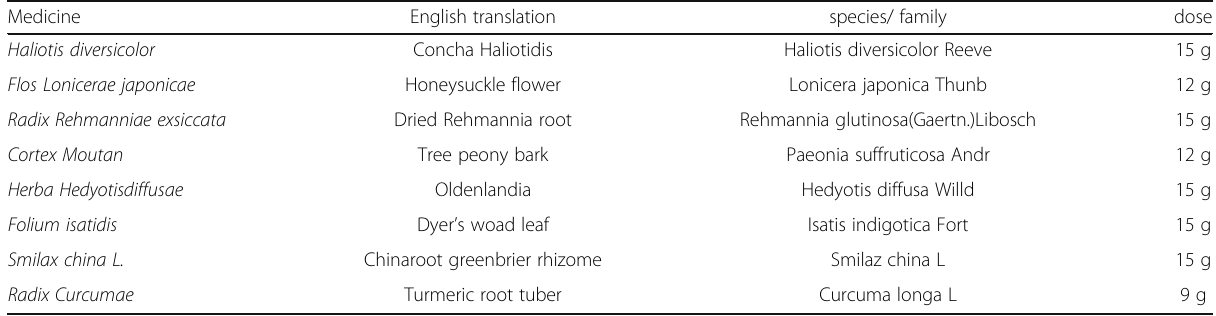
Table 1 Ingredients of JYG used with English translations